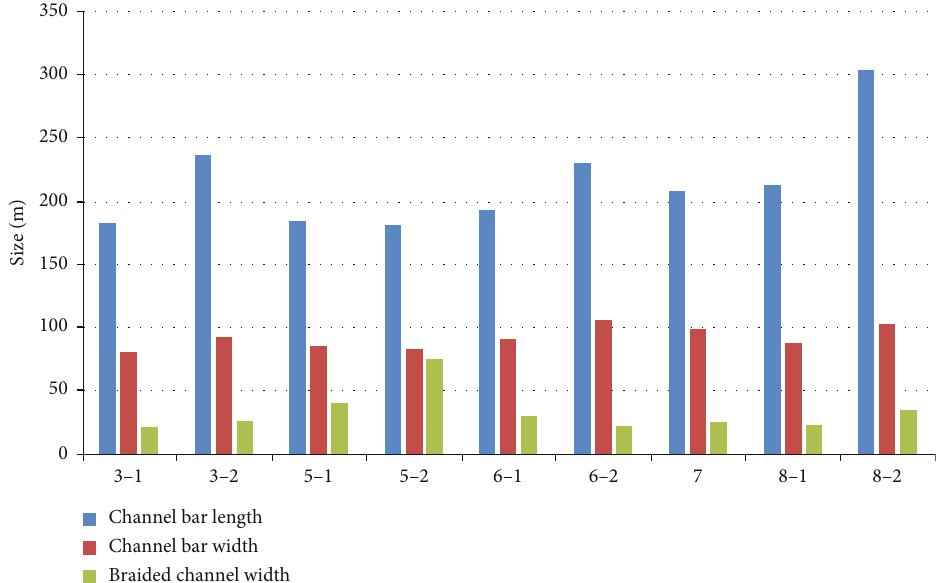
Figure 11: Quantitative statistical histogram of Nanpu 1-29 Area.